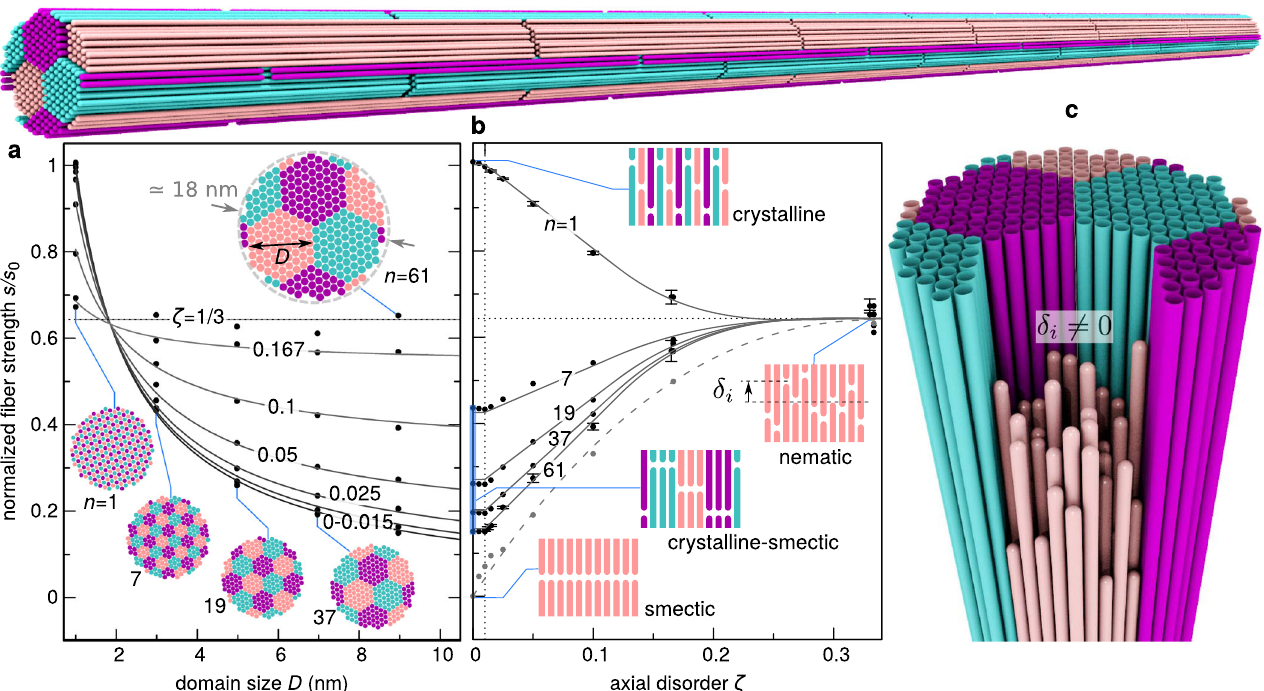
Fig. 2 Strength scaling in a fi nite-width fi ber. a Computed fi ber tensile strength (open circles) as a function of the domain size, s ( D ). The inset illustrates the domains and fi ber cross-sectional dimensions. The solid line shows the 1/ D -regression to the computed data points. b Fiber strength scaling with the axial disorder ζ . Error bars are provided for the n = 1 and n = 61, obtained from averaging over three random realizations for the same ζ . The solid lines in a and b are obtained by fi tting the empirical relationship, s ( D , ζ ) = a ( ζ ) + b ( ζ )/( D + c ) to the computed data points, where a ( ζ ), b ( ζ ) are piecewise polynomial functions and c is a constant (see details in Supplementary Note 4). The dashed line in b represents the case where n → ∞ or when one domain extends over the entire fi ber width. c Perspective view of the fi ber showing the brush-pattern interface due to the axial misalignment. The top image is a rendering of the entire simulated fi ber for the case of largest domains ( n =